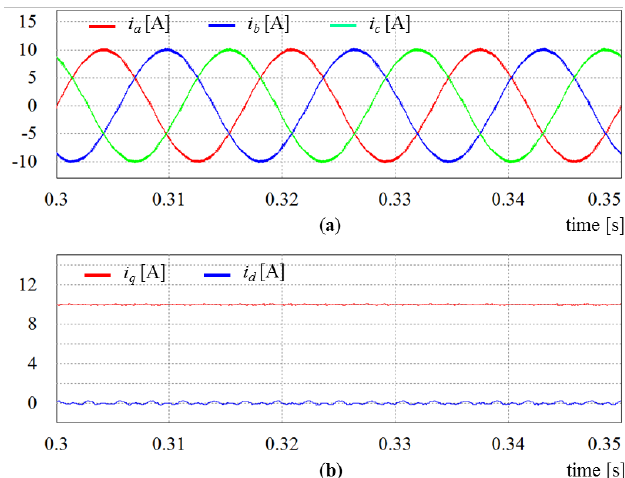
Figure 13. Inverter currents of the proposed control scheme under the distorted grid voltages: ( a ) phase-currents; and ( b ) q- axis and d- axis currents.